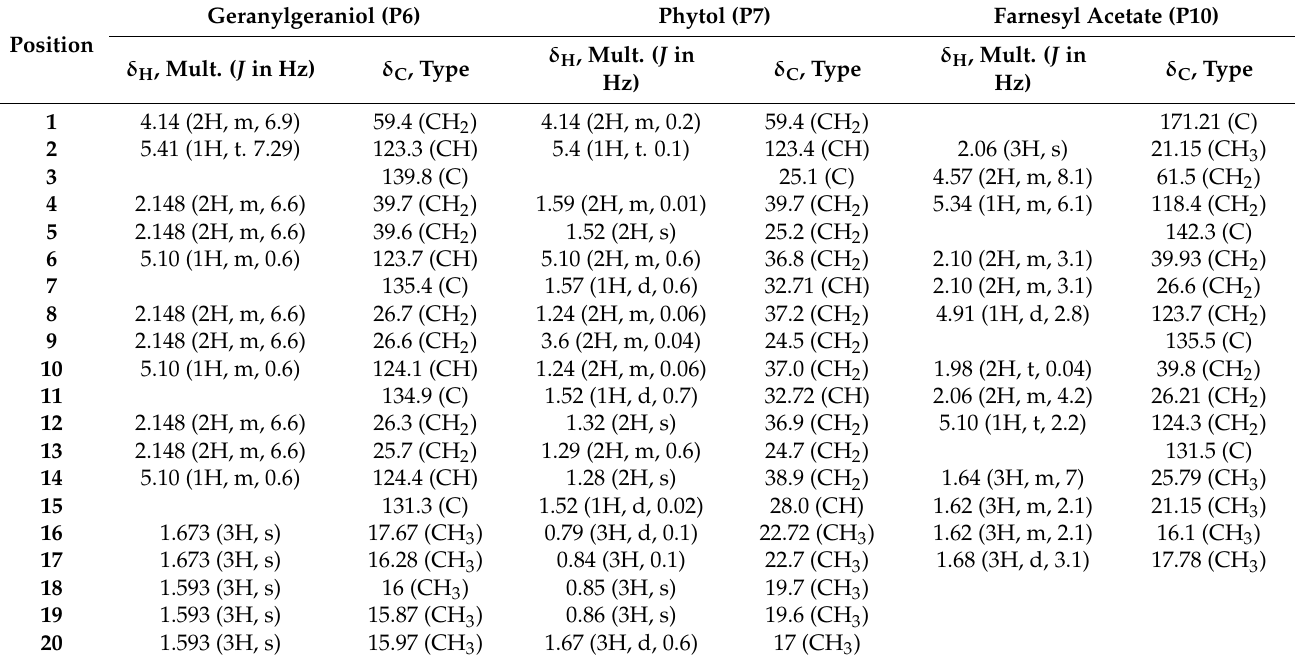
Table 3. 1 H and 13 C (300 MHz) NMR data of compounds geranylgeraniol (P6), phytol (P7) and farnesyl acetate (P10) in CDCl3.